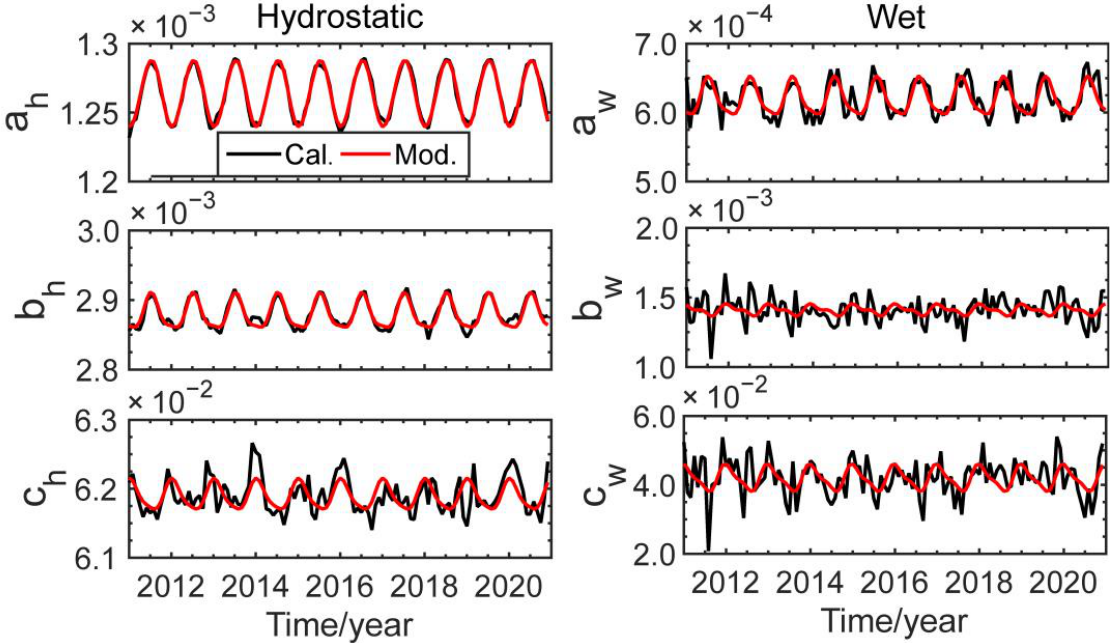
Figure 2. Calculated (black line) and modeled (red line) mapping function coefficients at JFNG station.